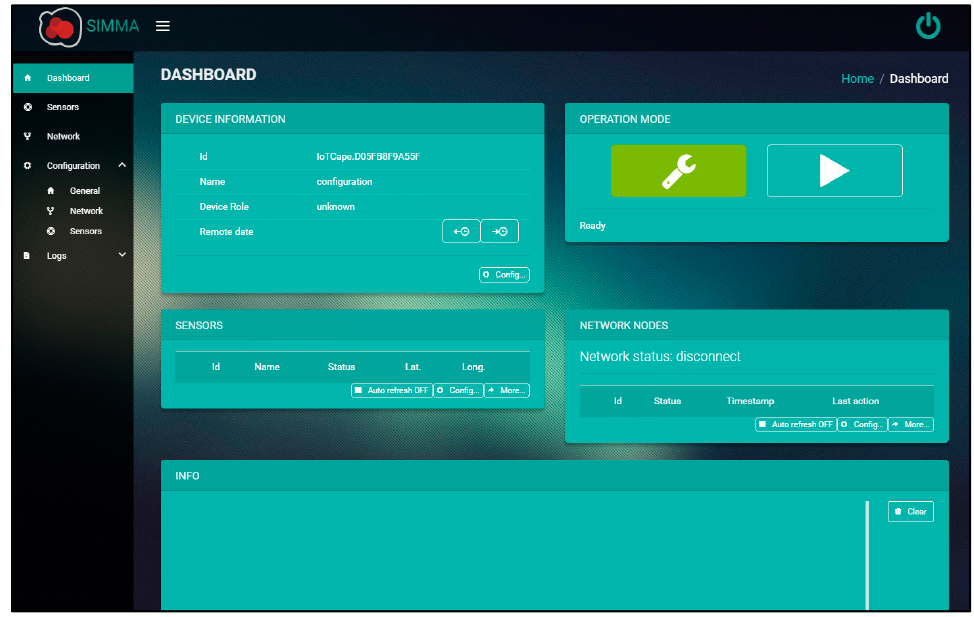
Figure 12. Graphical user interface screenshot.